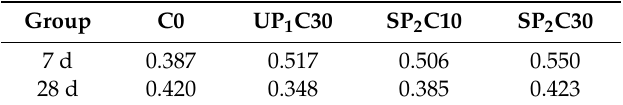
Table 4. Generation of Ca(OH) 2 for corresponding representative groups based on calculation by DTG curves